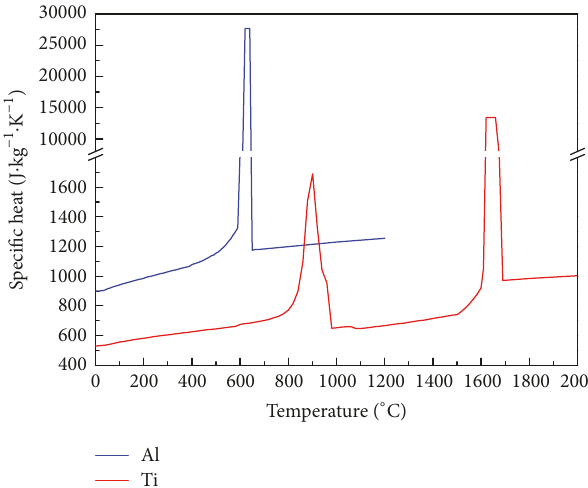
Figure 3: Specific heat of the Ti (Grade 2) and Al (AW 5754) alloy.